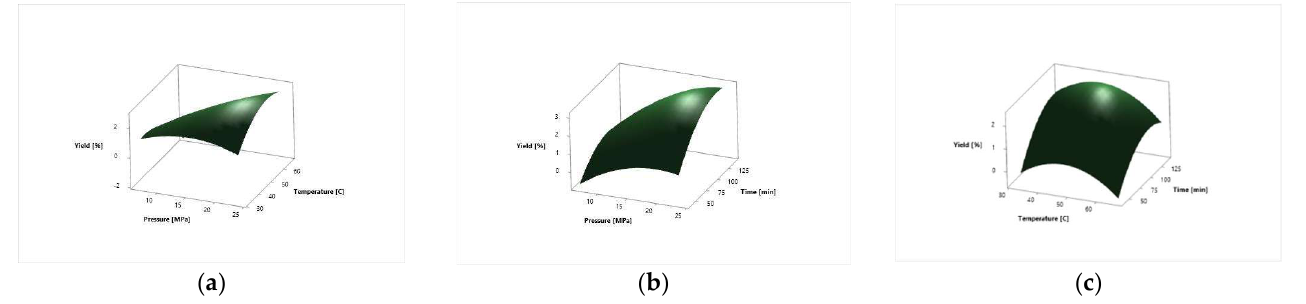
Figure 1. Surface response plots for the N. tabacum cv. Samsun leaves extraction yield in a function of extraction: ( a ) pressure and temperature; ( b ) pressure and time and ( c ) temperature and time. The surface response plots for the effect of independent variables on the N. tabacum cv. Virginia leaves total extraction yield [%] are depicted in Figure 2.